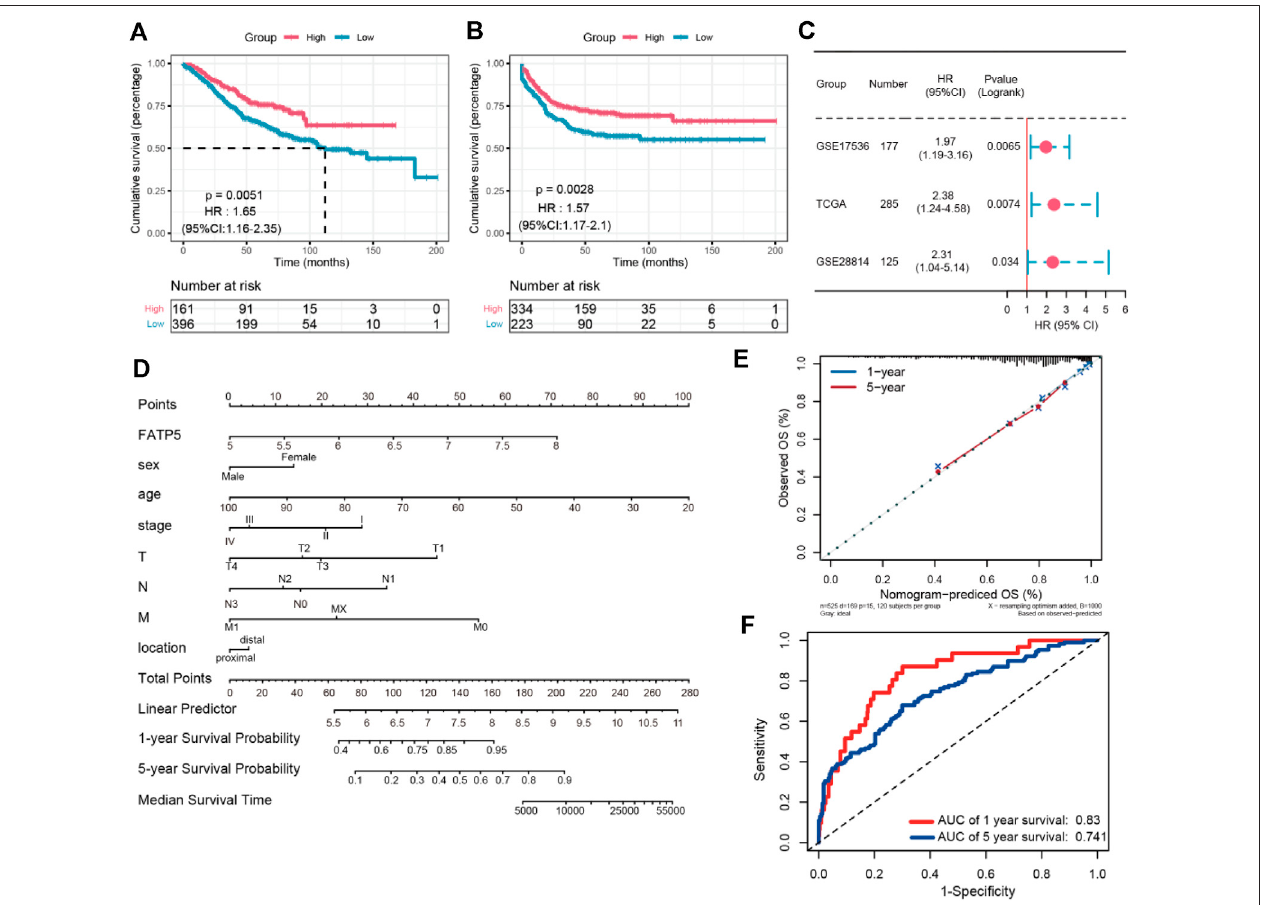
FIGURE 3| The survival analysisof FATP5 in human colorectal cancer. The overall survival (A) and relapse free survival (B) ofFATP5 in colorectal cancer based on GSE39582accession. (C) ThesurvivalanalysisofFATP5inGSE17536,GSE28814andTCGAcoloncohorts. (D) Anomogramconsistingofriskscoreandotherclinical indicators for predicting 1-, and 5-years OS of CRC. (E) Calibration plot of nomogram for predicting probabilities of 1, and 5-years overall survival of patients. (F) Time- dependent ROC for 1-, and 5-years OS predictions for the nomogram compared with actual observations.